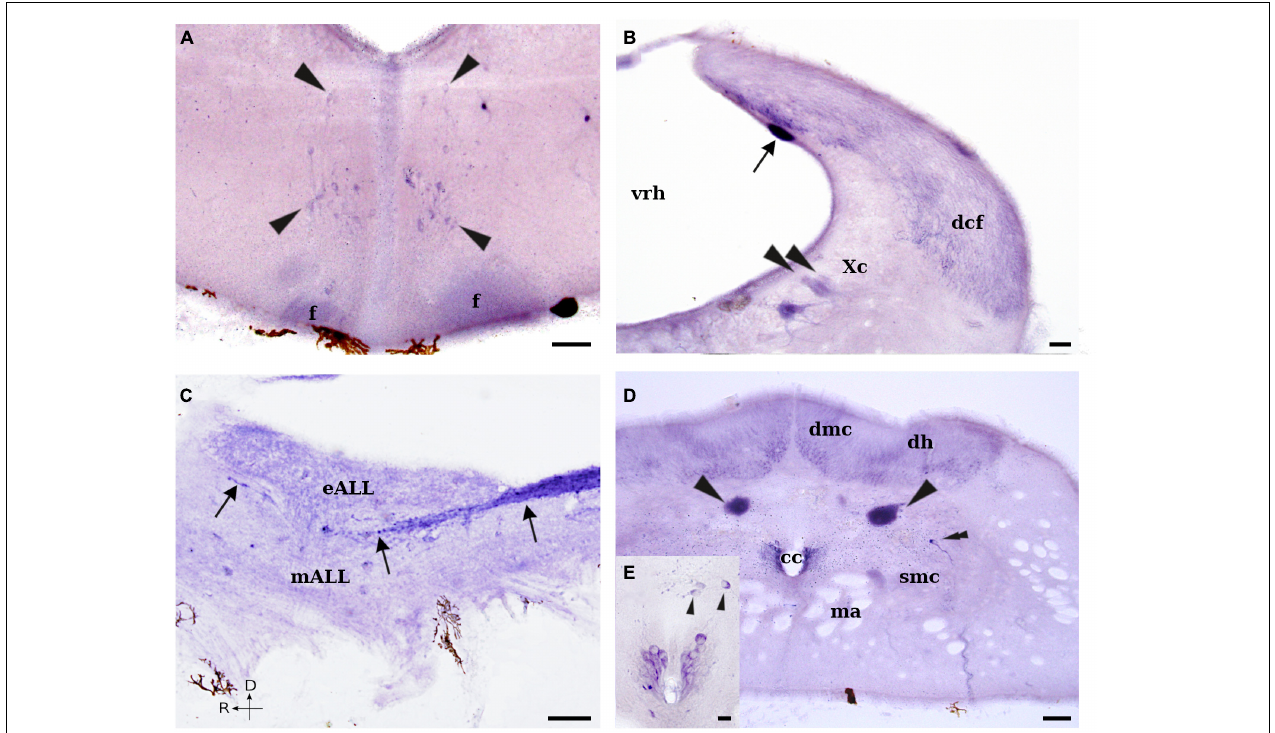
FIGURE 7 | Photomicrographs showing NADPH-d positive cells and fibers in the rhombencephalon and rostral spinal cord of L. fluviatilis . (A) Transverse section showing some NADPH-d positive cells (arrowheads) close to the midline in the rostral part of the rhombencephalon. Note also the presence of labeled fibers in the fasciculus retroflexus (f). (B) Transverse section through the caudalmost rhombencephalon showing a strong labeled sensory dorsal cell (arrow) and many labeled fibers in the dorsal column tract (dcf). Note also the presence of some weakly labeled cells in the caudal part of the vagal motor nucleus (Xc; arrowheads). (C) Sagittal section showing NADPH-d labeled fibers of the dorsal column tract ascending toward the dorsal isthmic region (arrows). (D) Transverse section showing NADPH-d positive cells in the rostral part of the lamprey spinal cord. Two strong NADPH-d labeled sensory dorsal cells are located in each side of the cord (arrowheads), whereas a single labeled cell (double arrowhead) is present dorsolateral to the spinal motor column. Note also the presence of several labeled CSF-c cells at both sides of the central canal (cc), as well as many labeled fibers in the dorsomedial column (dmc) and the dorsal horns (dh). (E) Higher magnification of the central canal of a parallel section showing the labeled CSF-c cells as well as some non-CSF-c cells dorsally displaced (arrowheads). Medial and rostral directions are oriented to the left in transverse and sagittal sections, respectively. For abbreviations, see list. Scale bar = 25 µ m.